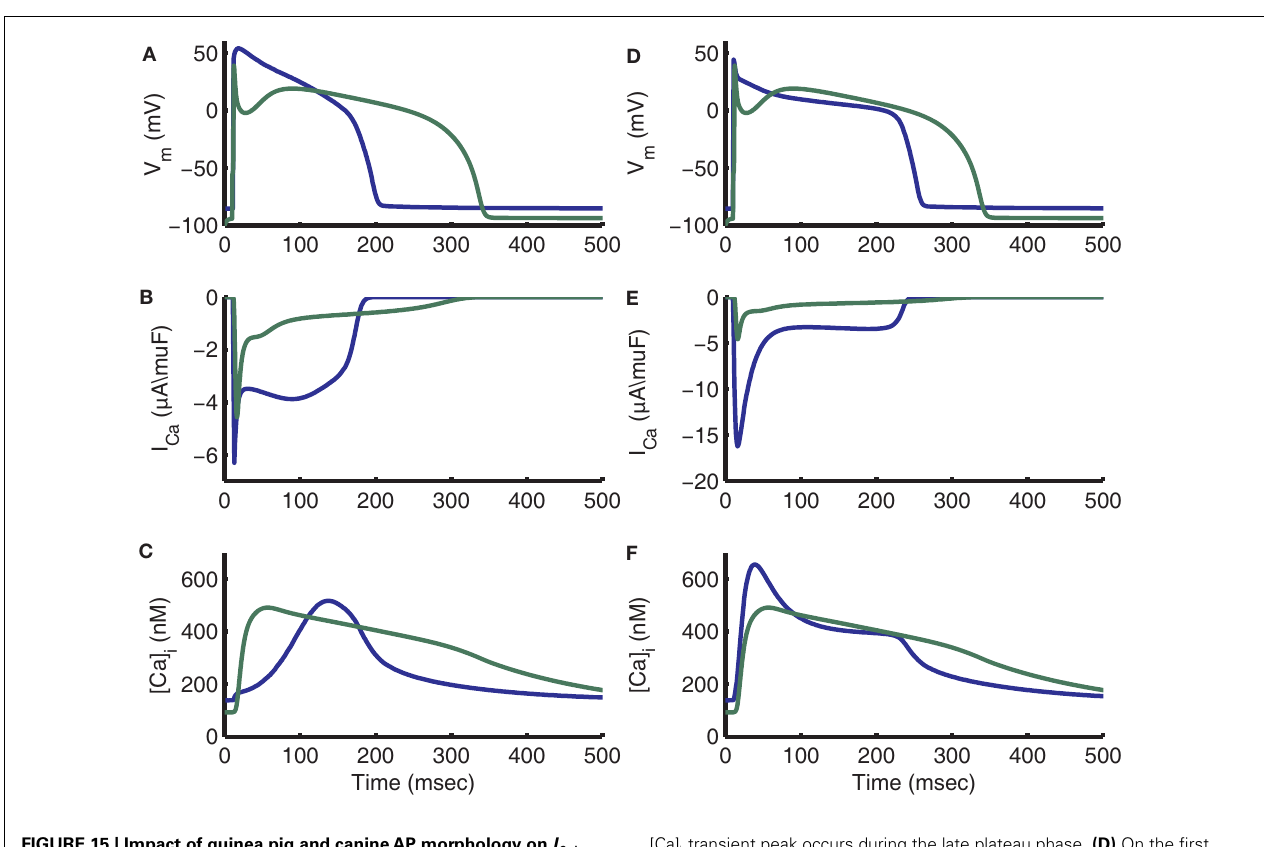
FIGURE 15 | Impact of guinea pig and canineAP morphology on I Ca,L and [Ca] i transients. In all panels blue traces are guinea pig model output and green traces are canine model output. (A) Comparison of APs from guinea pig and canine models (Greenstein et al., 2006).The canine AP has a significant early repolarization notch and a significantly longer APD. (B) L-type current traces peak near the same value, but guinea pig shows a much larger amount of late current. (C) Canine [Ca] i transient peak is approximately aligned with the AP notch, while the guinea pig